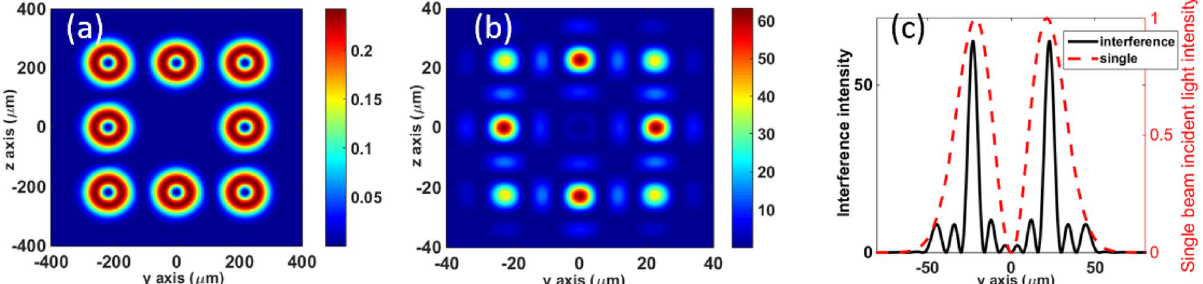
Figure 2. Numerical results. The peak intensity I 0 of the sub-beams is set to 1 at the waist plane x = 0. ( a ) Intensity distributions of the sub-beams at the source plane x = − 5 mm. See the Supplementary Fig. S1a for the phase distributions of the sub-beams at the source plane. ( b ) Intensity distributions of vortex light combined field at the waist plane x = 0. The energy keeps to accumulate towards four local spots during the propagation, which can be observed from the evolution process of the combined field (see the video of Supplementary Material 2). The peak intensity of the combined field is higher than 60 I 0 . See the Supplementary Fig. S1b for the phase distributions of the sub-beams at the waist plane. ( c ) Intensity distribution of the combined field on the y -axis at z = 0 at the waist